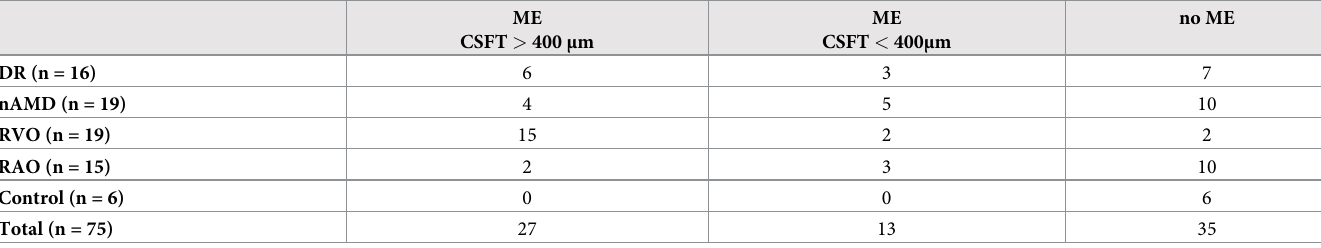
Table 2. Absolute frequency and central thickness of macular edema by diagnosis.